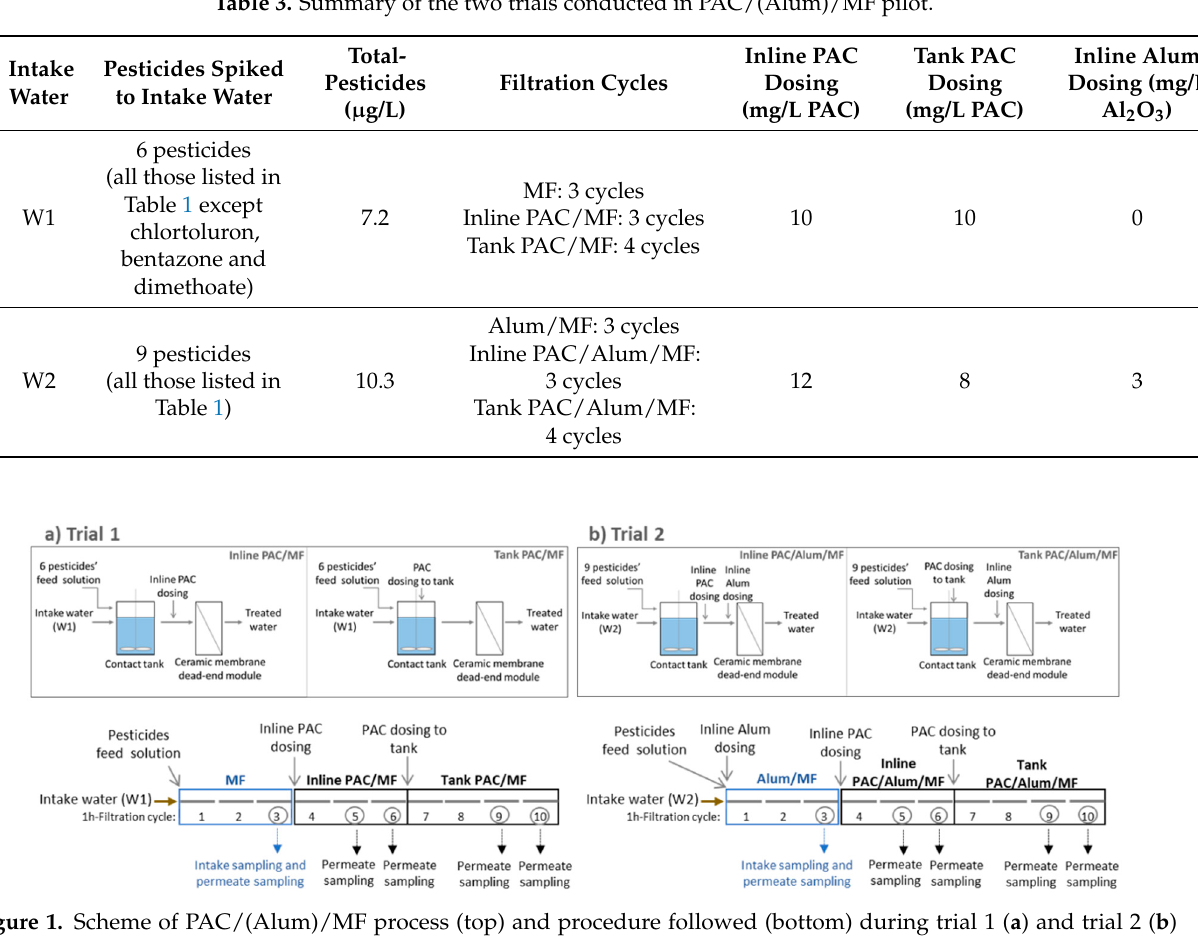
Table 3. Summary of the two trials conducted in PAC/(Alum)/MF pilot.